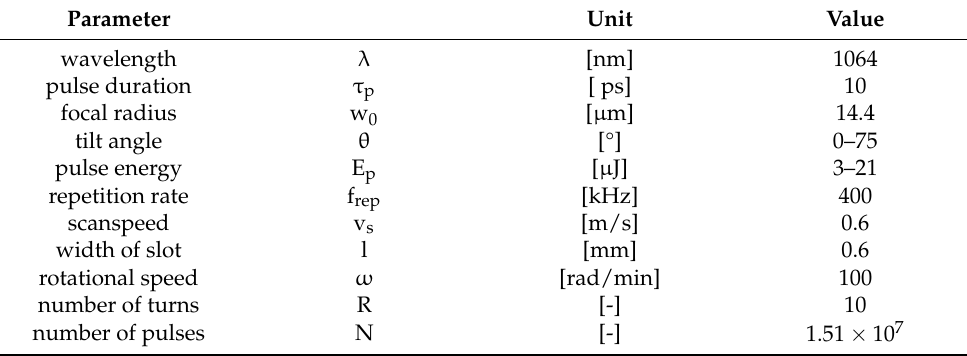
Table 2. Process parameters for the laser calibration